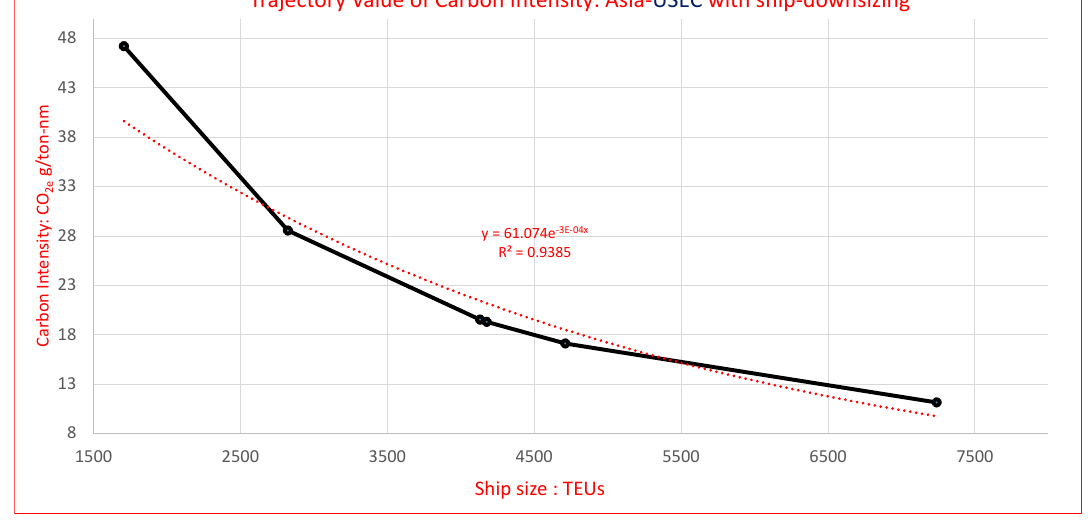
Figure 7. The Carbon Intensity against Ship Size of Route C-1.